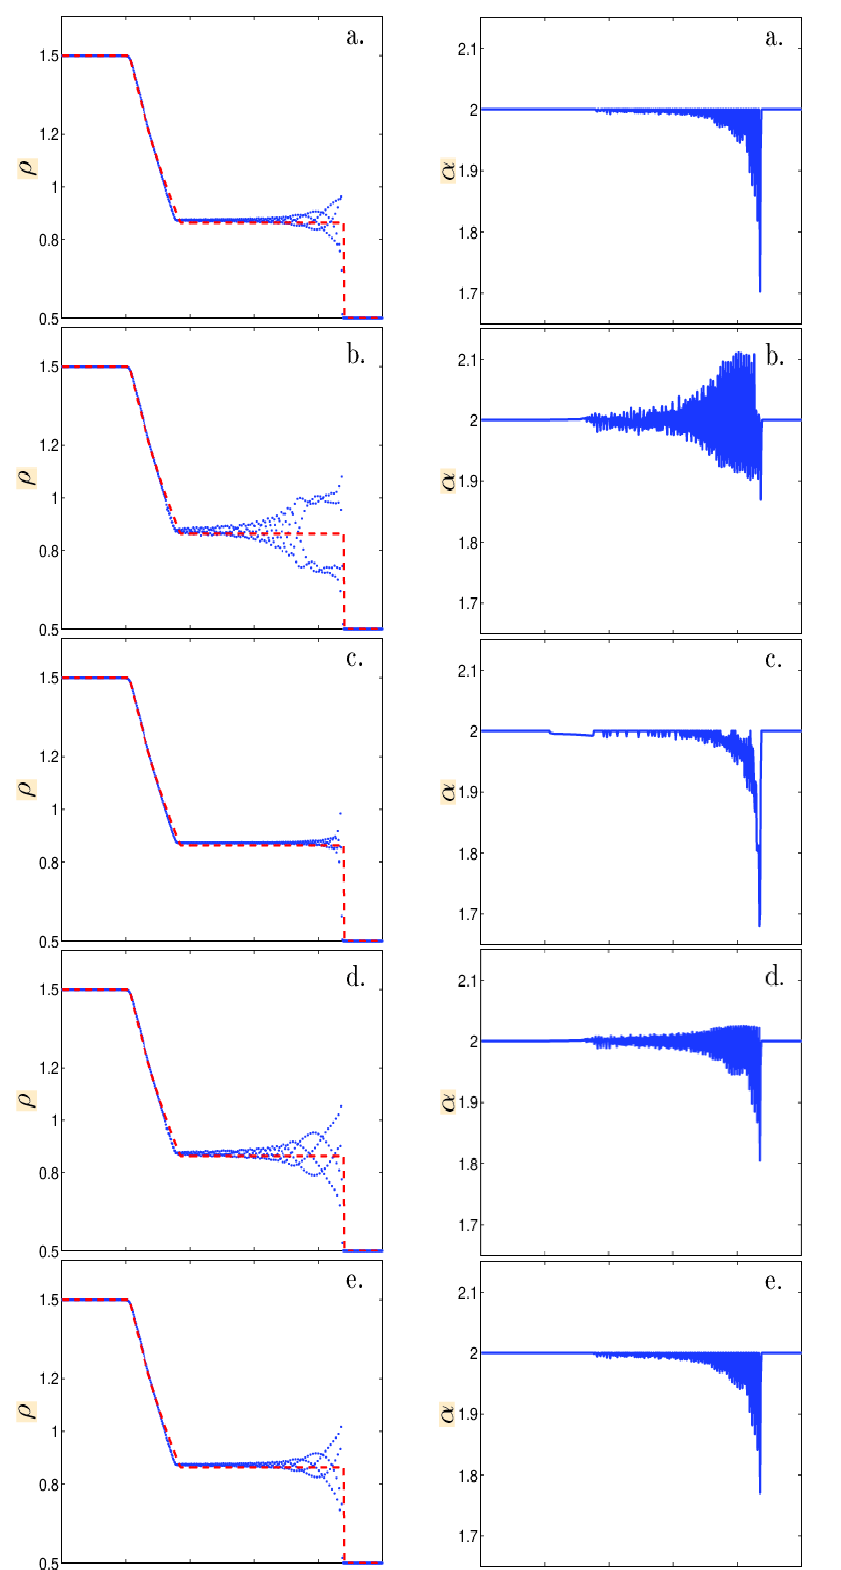
Figure 3. Sod shock tube. The density profiles ( left ) and α ( right ) are presented. From upper to lower slides: ( a ) α defined by (16); ( b ) LD method (Proposition 1); ( c ) first-order EELB method; ( d ) third-order EELB method; ( e ) Zhao–Yong method; dashed (red) line is the analytical